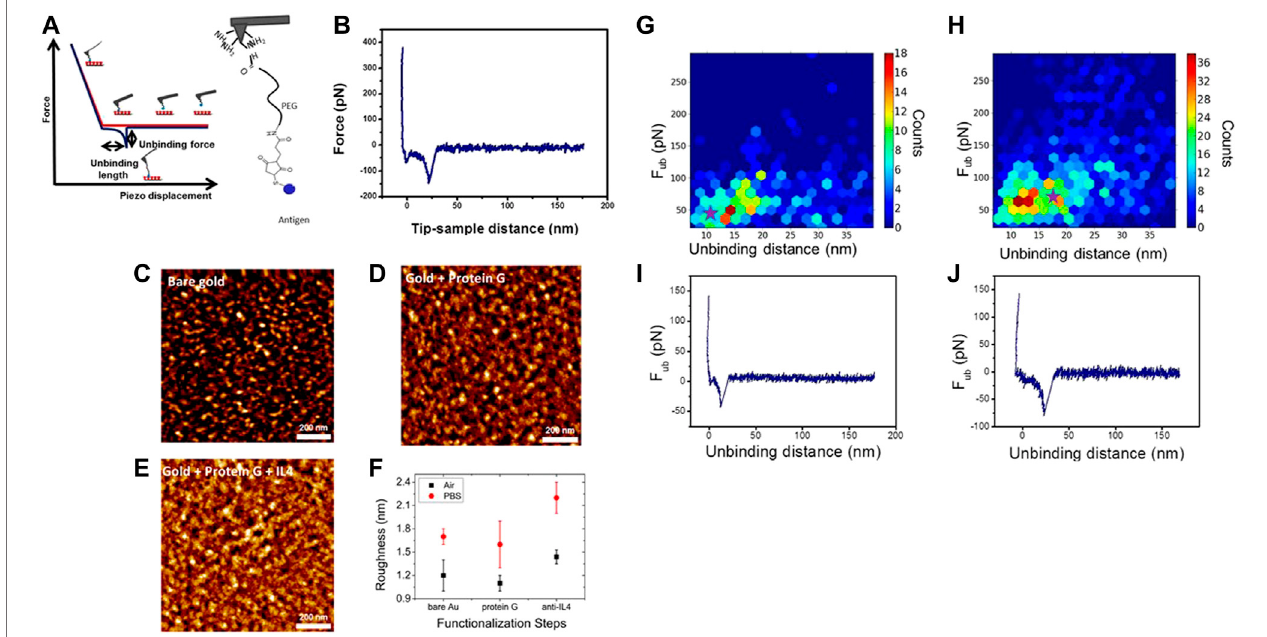
FIGURE 6 | (A) (Left) Schematic diagram of a force – distance curve: With the cantilever tip approaching toward the substrate, tip – sample contact occurs. The cantilever tip bends upward due torepulsive forces and the probe is retracted. When the recognition event occurs, the cantilever tip is bent downward due to adhesion. The cantilever tip jumps out of contact when force gradient becomes greater than the cantilever spring constant. The maximum adhesion force, calculated as the difference between the baseline and the minimum during retraction, is the rupture/unbinding force. (Right) L4 – PEG linker complex is adhered to an amino- decorated AFM cantilever tip. (B) Force – distance curve demonstrates a speci fi c rupture event. (C) AFM image of just gold. (D) AFM image of protein G (PG) – decorated gold. (E) AFM image of anti-IL4 + PG – plated gold. (F) Roughness measurements of the samples shown in (C – E) were performed in air and in PBS solution with AFM. RoughnessdecreasesuponPGdepositionbutincreasesfollowingtheantibodycoatinginbothairandPBS. (G – H) Histogramsoftheunbindingdistanceandunbinding forcein twodimensionsusing the HSC 6 NH 2 -based protocol PG-based protocol, respectively. (I – J) Force vs. tip sample separatingdistanceplots corresponding tothe hexagons marked with stars in (G ) and (H), respectively ( Casalini et al., 2015 )